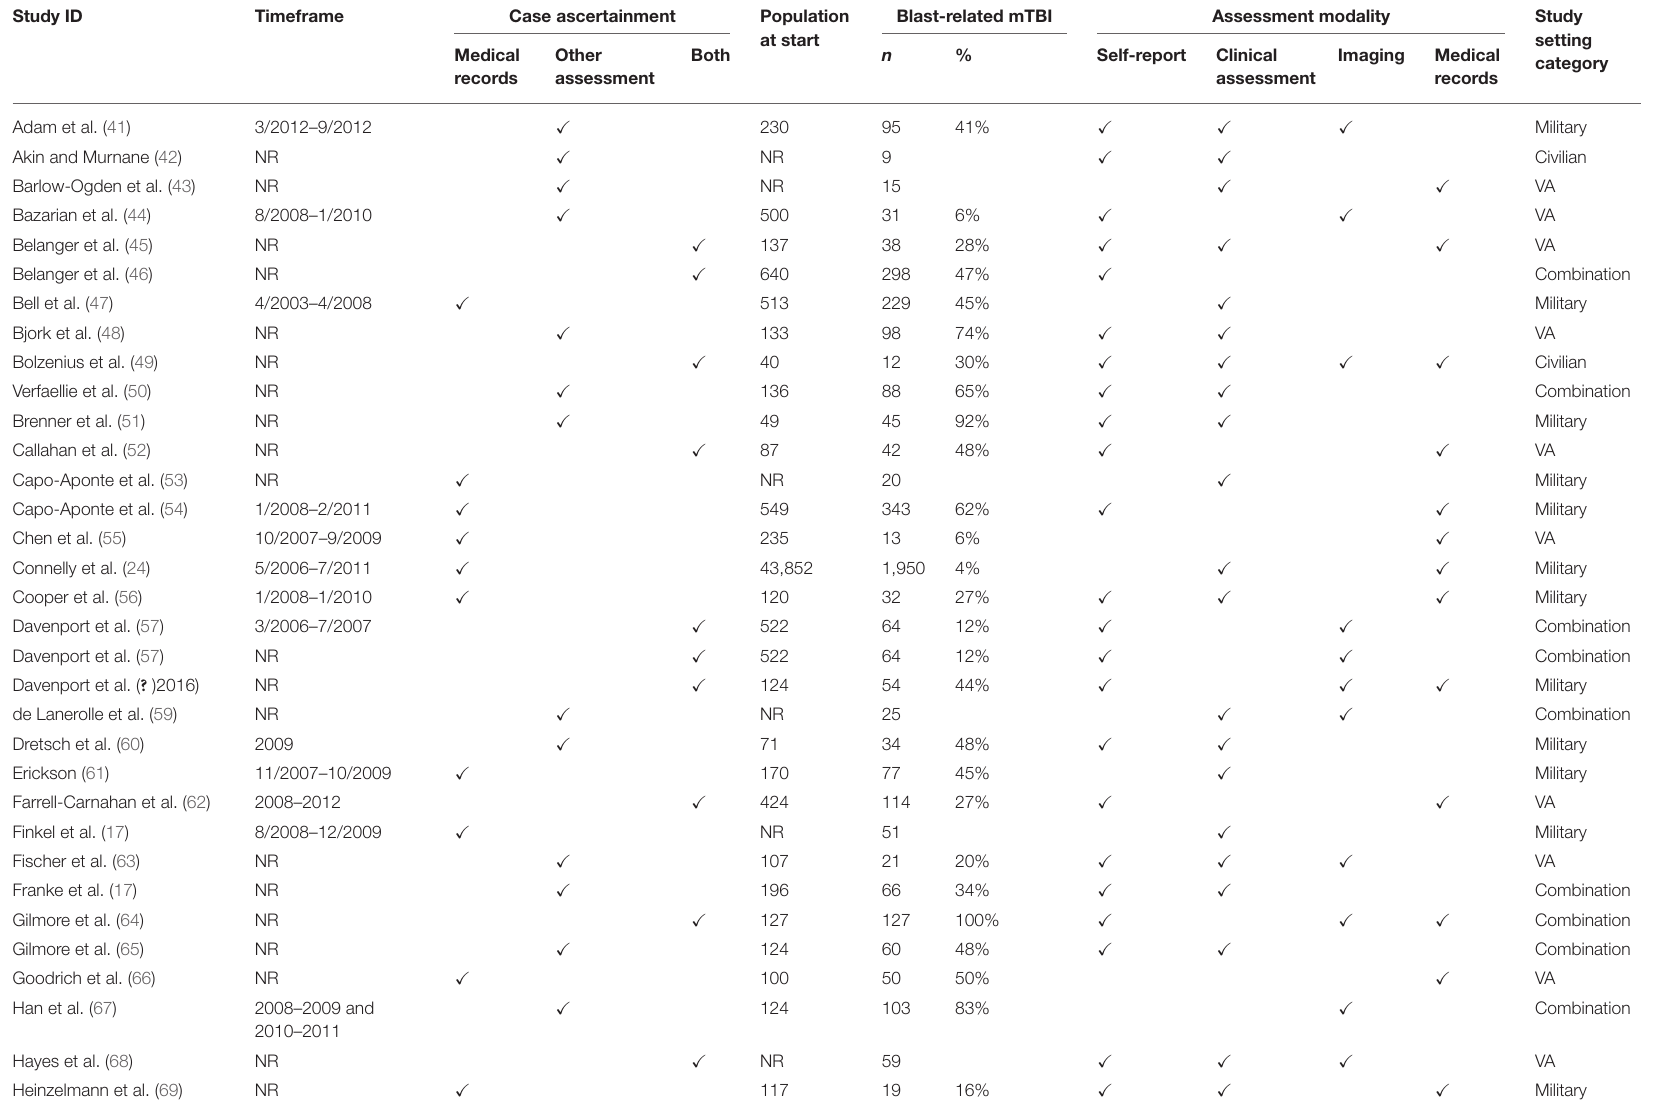
TABLE 4 | Characteristics of included